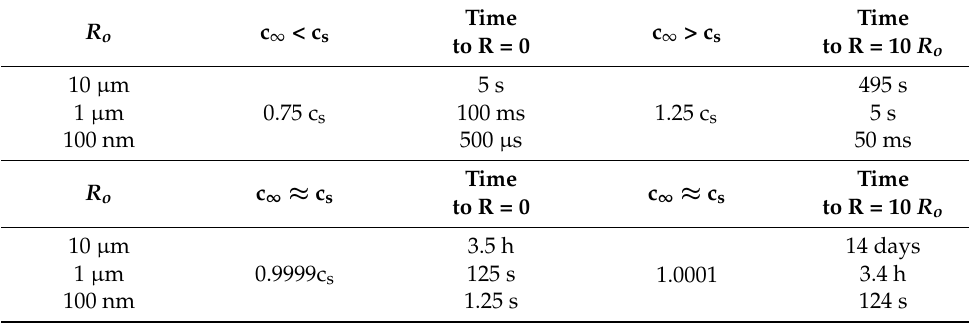
Table 1. Dissolution and expansion of different size bubbles at various